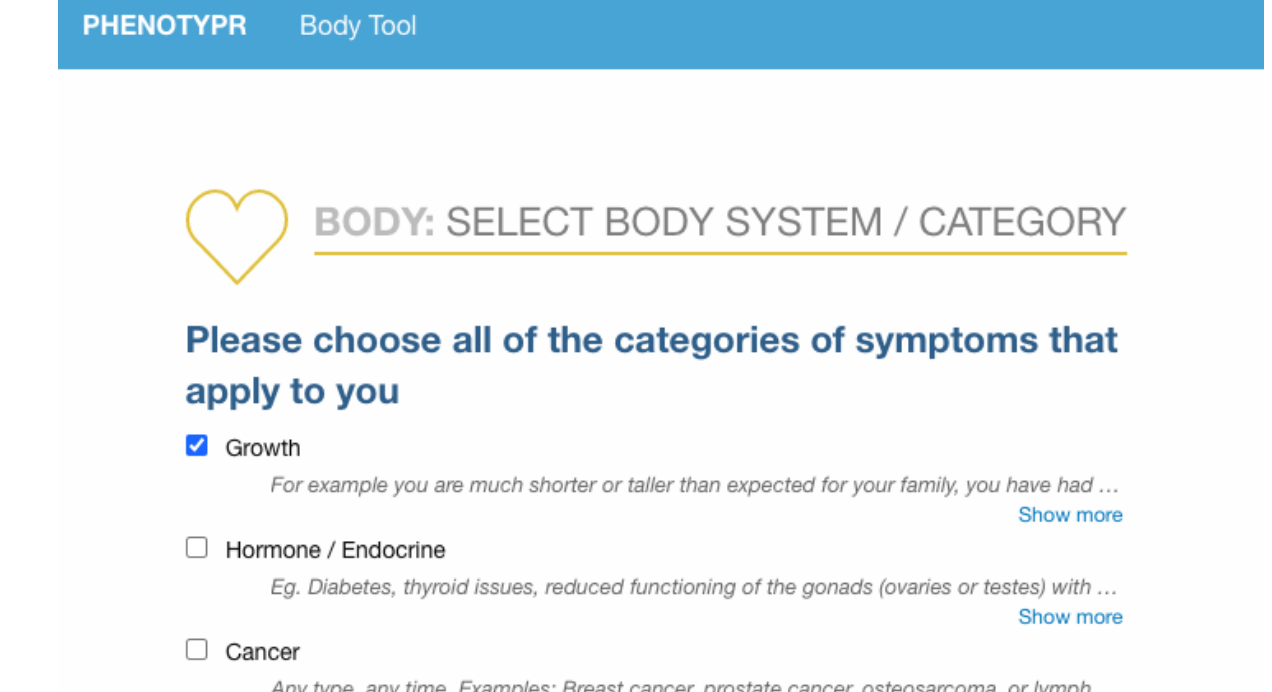
Figure 1. Data entry for Phenotypr: relevant body system